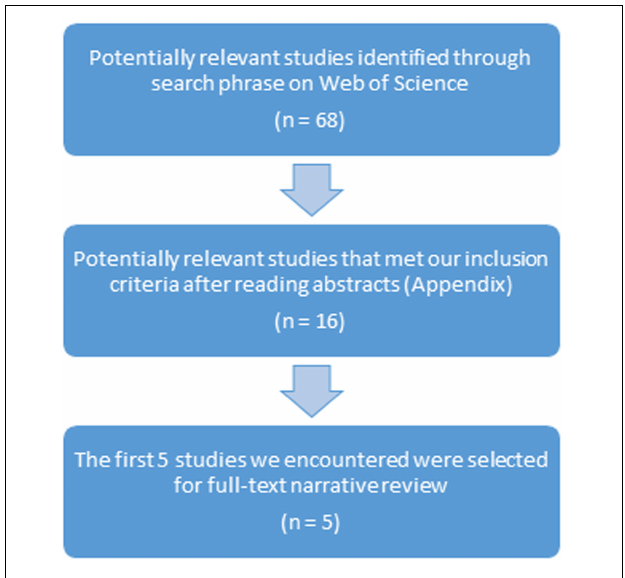
FIGURE 1 | Process of selection of five meta-analytic studies for narrative review.